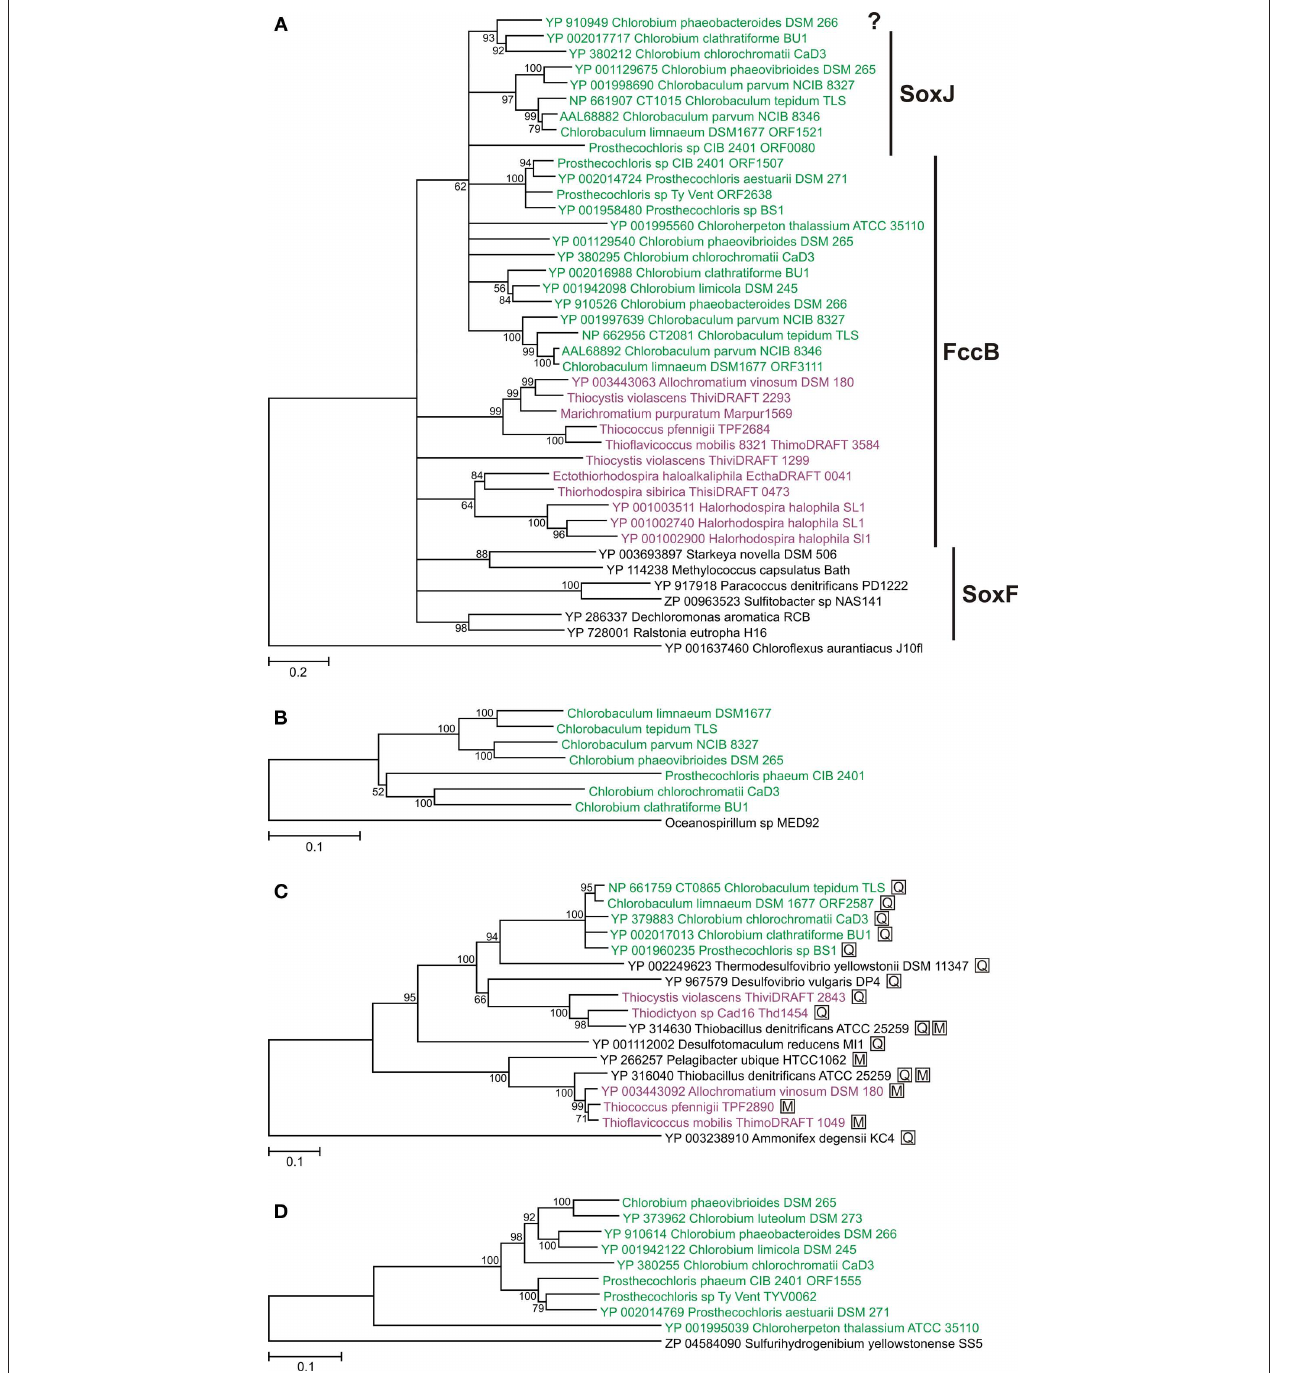
SoxXYZAKB proteins (CT1016–CT1021 in Cba. tepidum ). The three is rooted with the same proteins from Oceanospirillum sp. MED92. (C) Adenosine-5 ′ -phosphosulfate reductase alpha subunit (AprA). The three is rooted with a homologous protein from Ammonifex degensii . Proteins marked with a boxed “M” indicate that the organism has AprM; proteins marked with a boxed “Q” indicate that the organism has Qmo proteins. (D) Polysulfide reductase-like complex 3 (PSRLC3). The three is rooted with a homologous protein from Sulfurihydrogenibium yellowstonense . The PSRLC3 protein from Chl. phaeovibrioides DSM 265 used here was constructed by restoring a frameshift mutation in the gene ( Table 1 ). See text